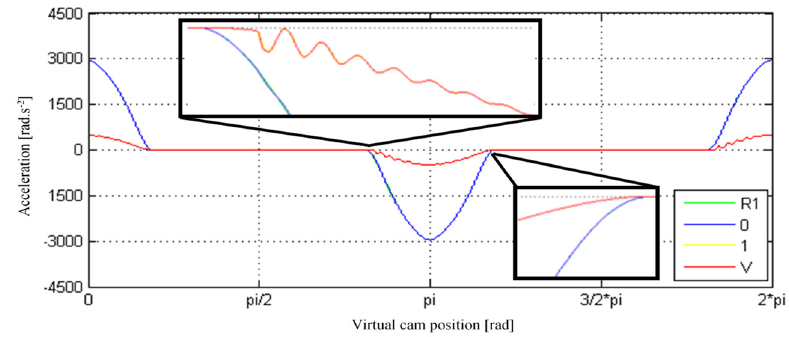
Figure 12. Courses of angular accelerations of individual drive system elements.